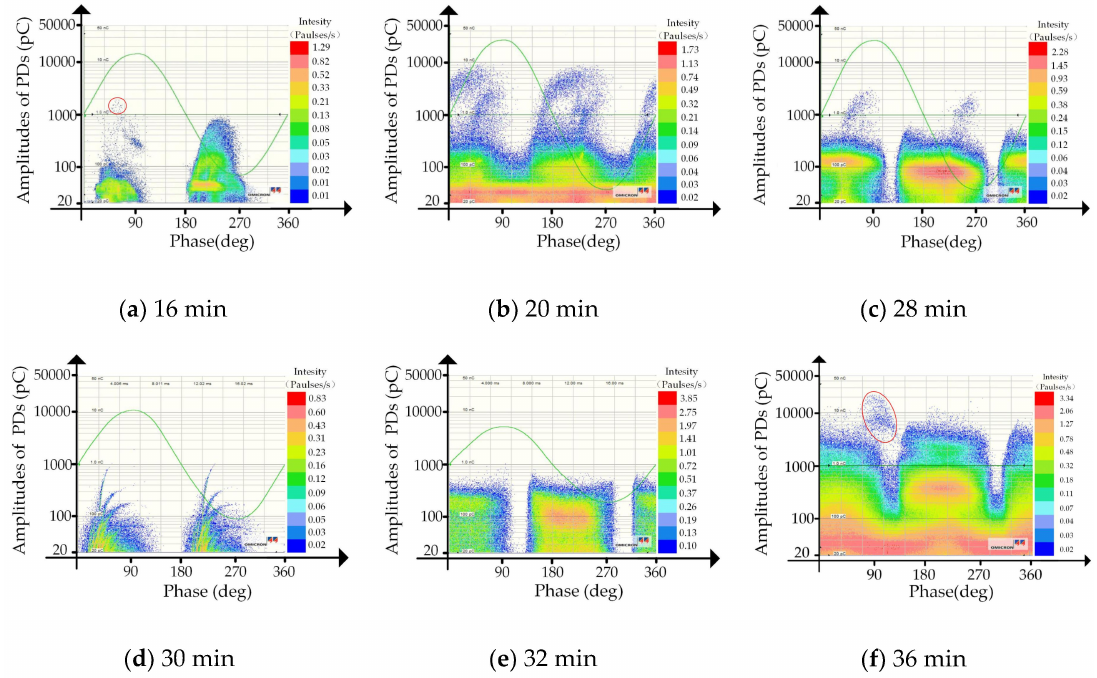
Figure 7. The development process of PD under 4 µ m